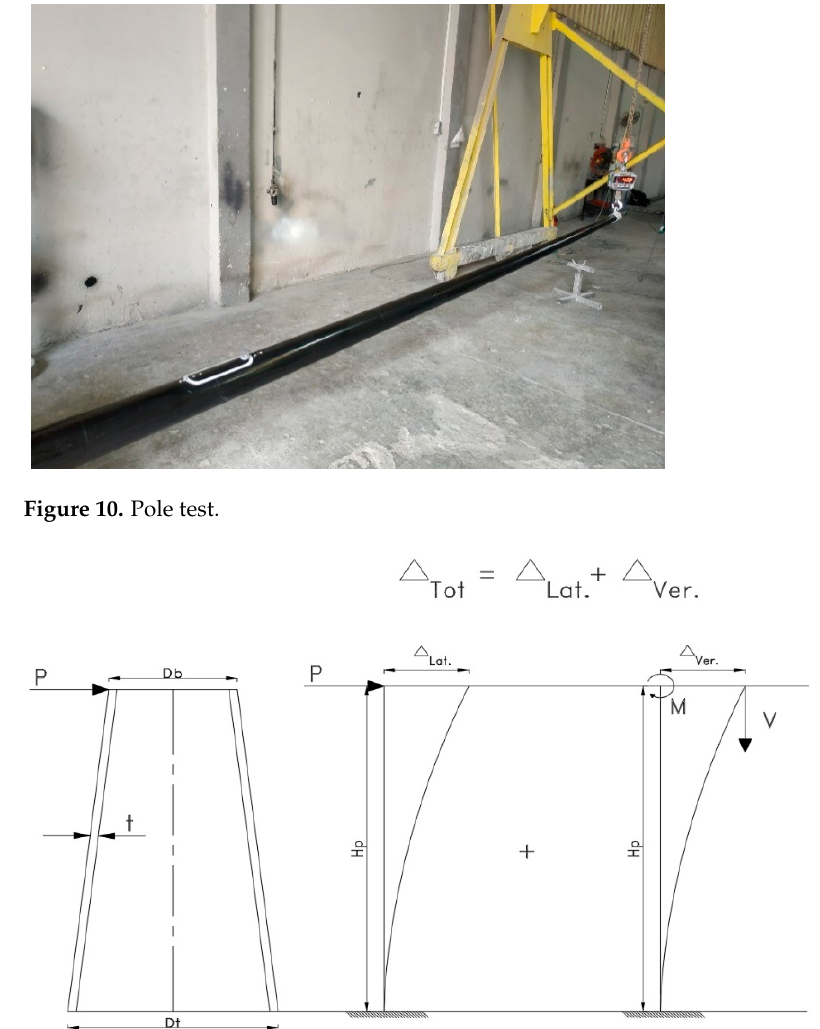
Figure 11. Pole deflection, adapted from Ref.